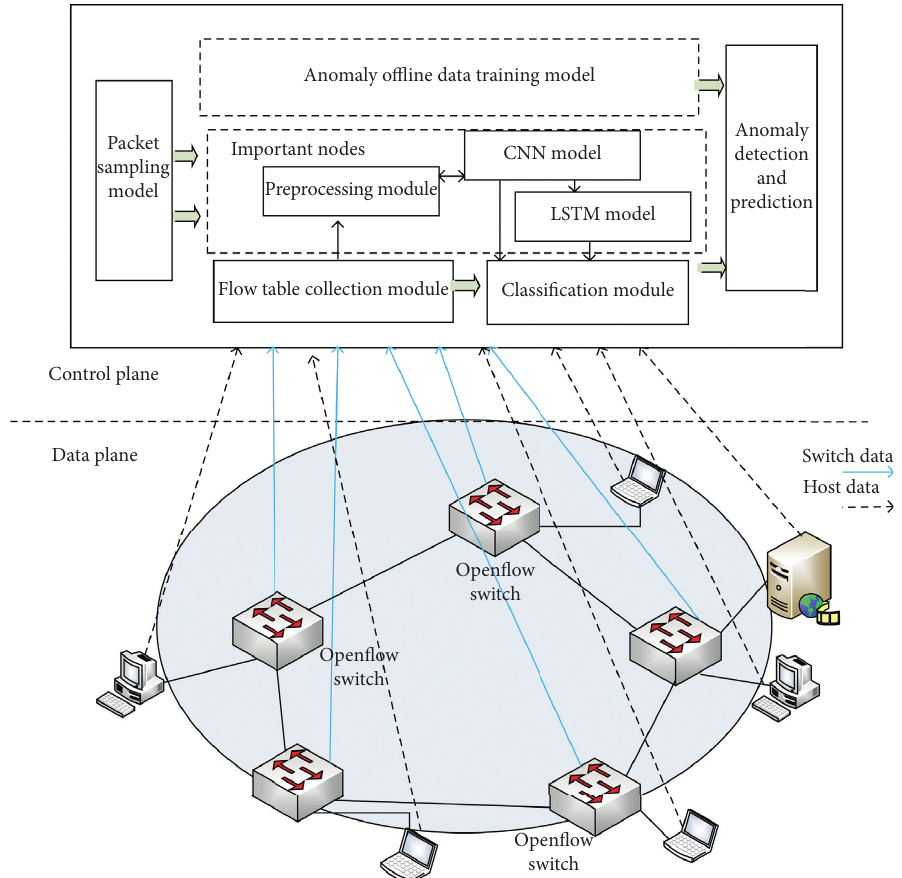
Figure 1: Deep learning-based network security data sampling and anomaly prediction